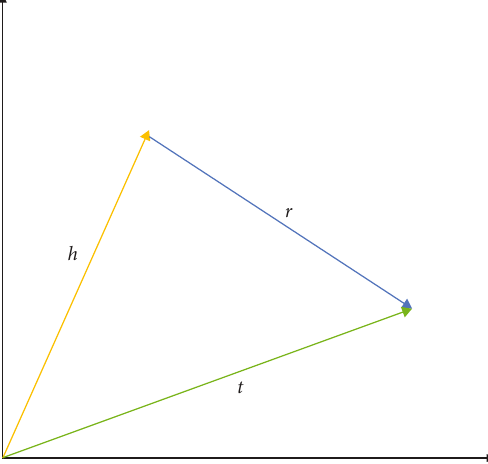
Figure 4: Knowledge graph representation learning based on TransE